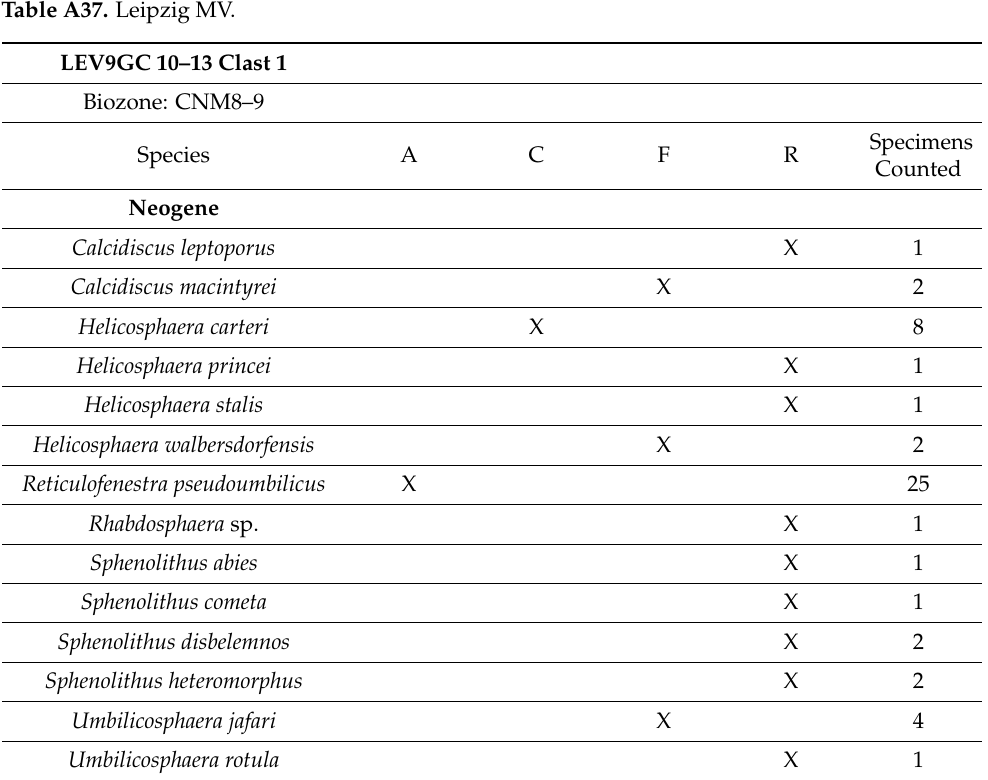
Table A37. Leipzig